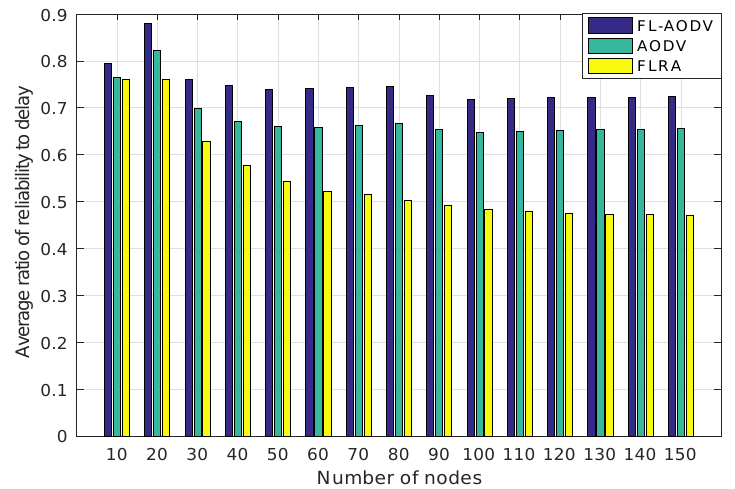
Figure 12. Comparison of average reliability to delay